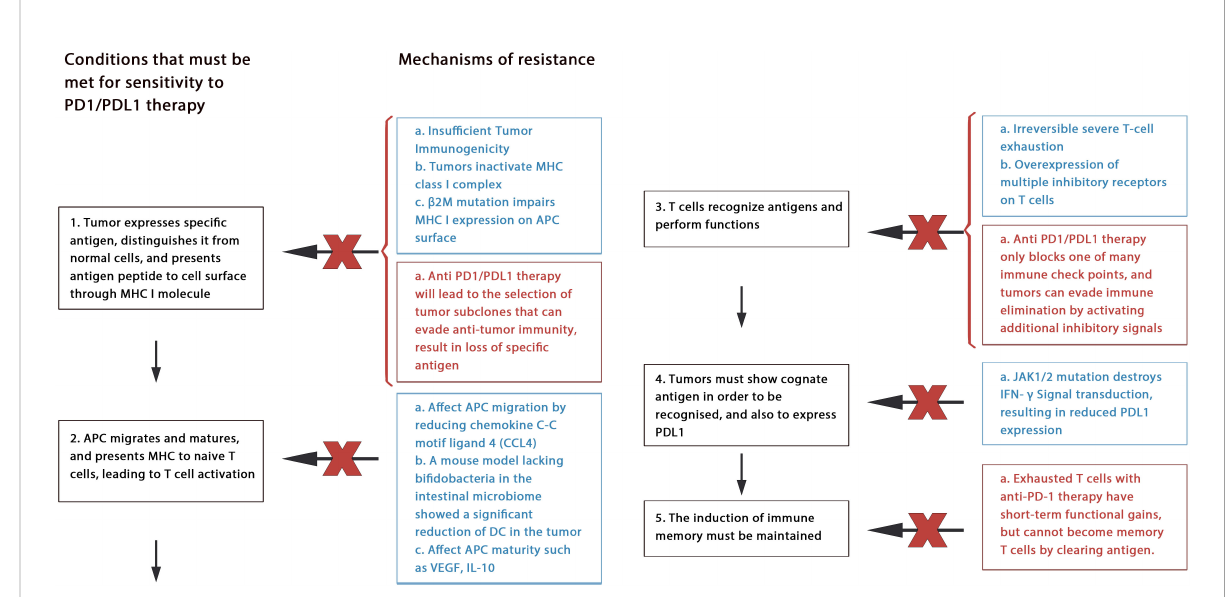
FIGURE 3 Mechanism of drug resistance: Blue text represents primary resistance, red text represents acquired resistance.